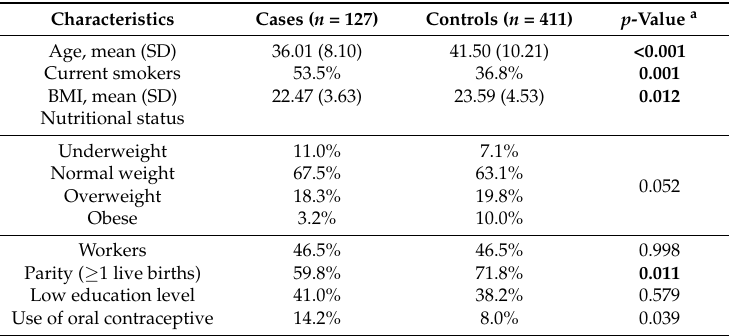
Table 2. Characteristics of women according to case/control